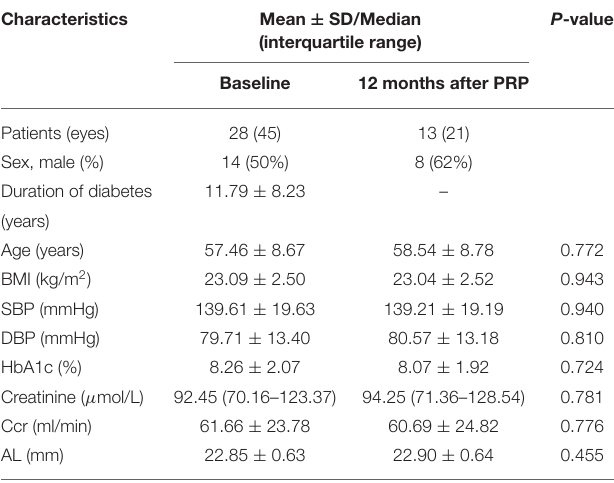
TABLE 1 | Demographic and systemic characteristics of the participants.